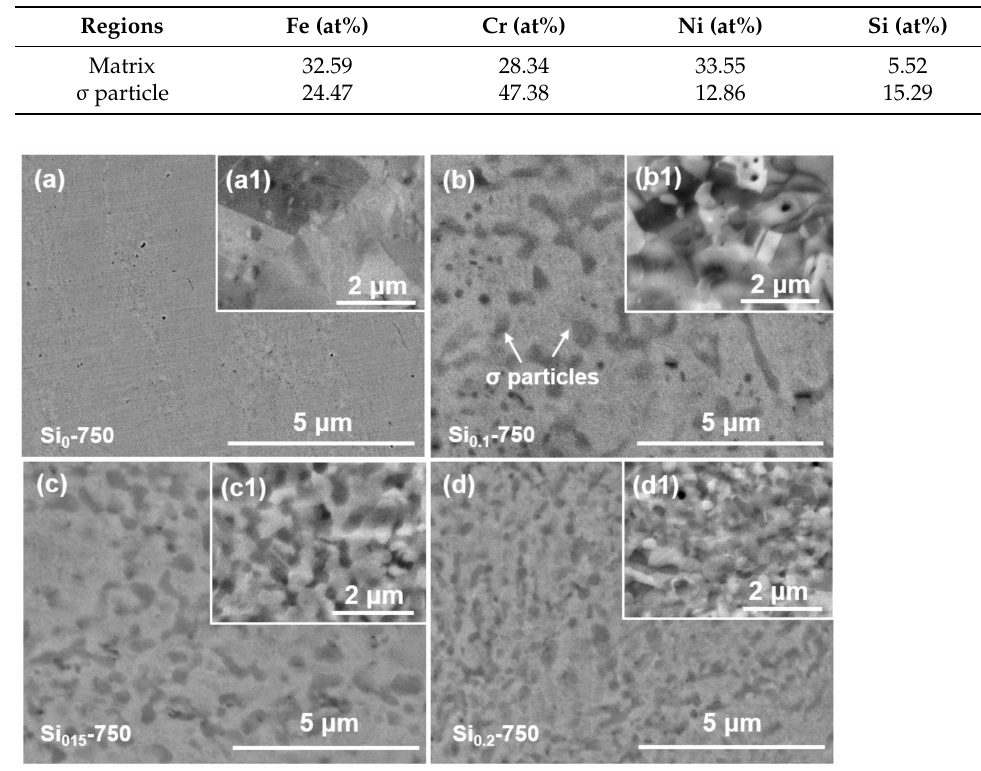
Table 1. Chemical composition of the marked points in the Si 0.15 -750 MEA.